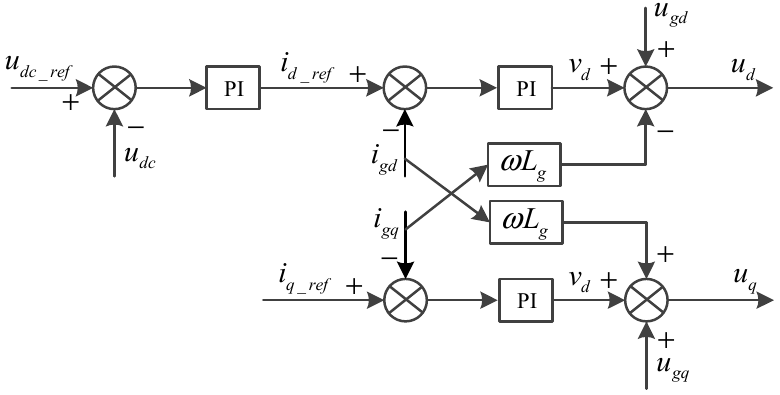
Figure 4. Dual closed-loop control system structure.